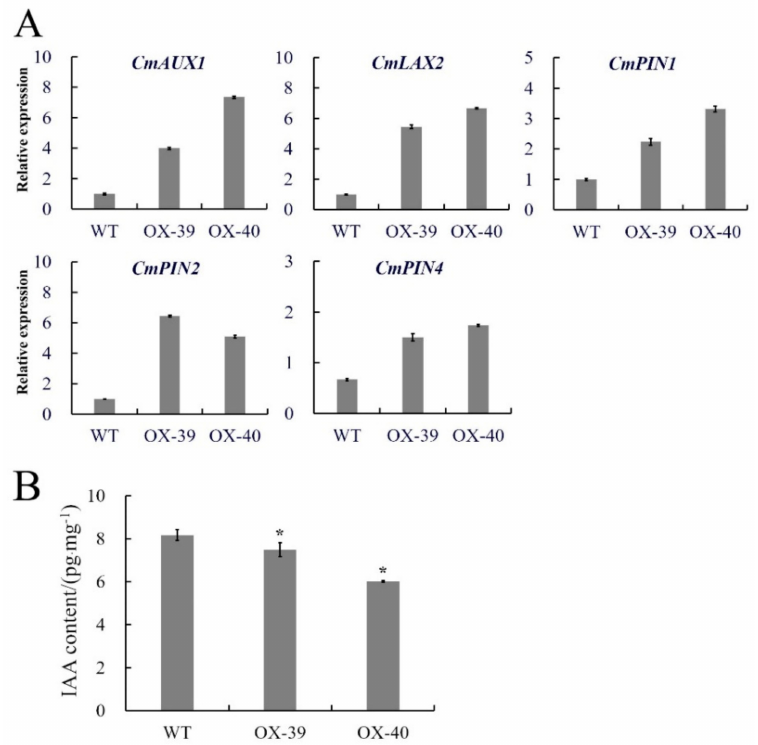
Figure 6. Di ff erences in transgenic CmSWEET17 overexpression lines. ( A ) Relative gene expression and ( B ) IAA content analysis of WT and overexpression lines (OX-39 and OX-40). * p ≤ 0.05 vs. WT. WT, wild-type and IAA, indole-3-acetic